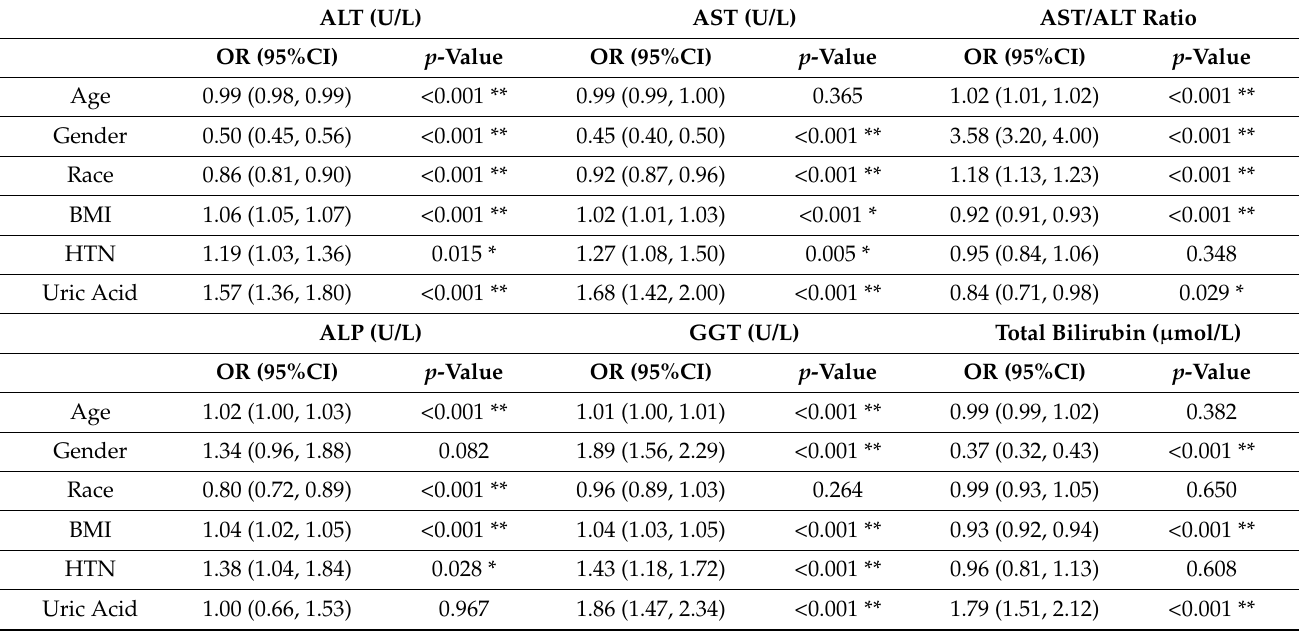
Table 5. Predictors of Liver Enzymes on Regression (Adjusted